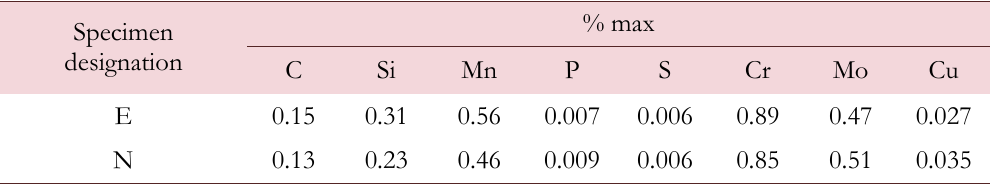
Table 1: Chemical composition of exploited (E) and new (N) PM specimens